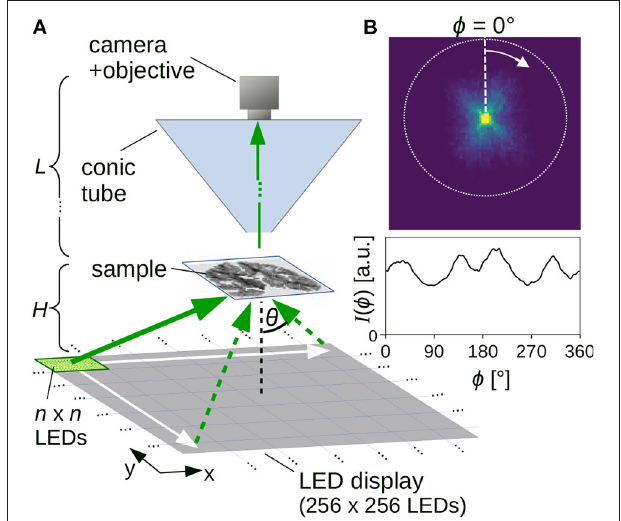
FIGURE 1 | (A) Setup for Scattered Light Imaging (SLI) scatterometry measurement. (B) Example of measured scattering pattern (obtained from an SLI scatterometry measurement with 2 × 2 illuminated LEDs and 81 × 81 kernels, shown in Figure 5C ii) with corresponding azimuthal line profile (integrated from the center to the outer border, evaluated in steps of 1φ = 1 ◦ ).